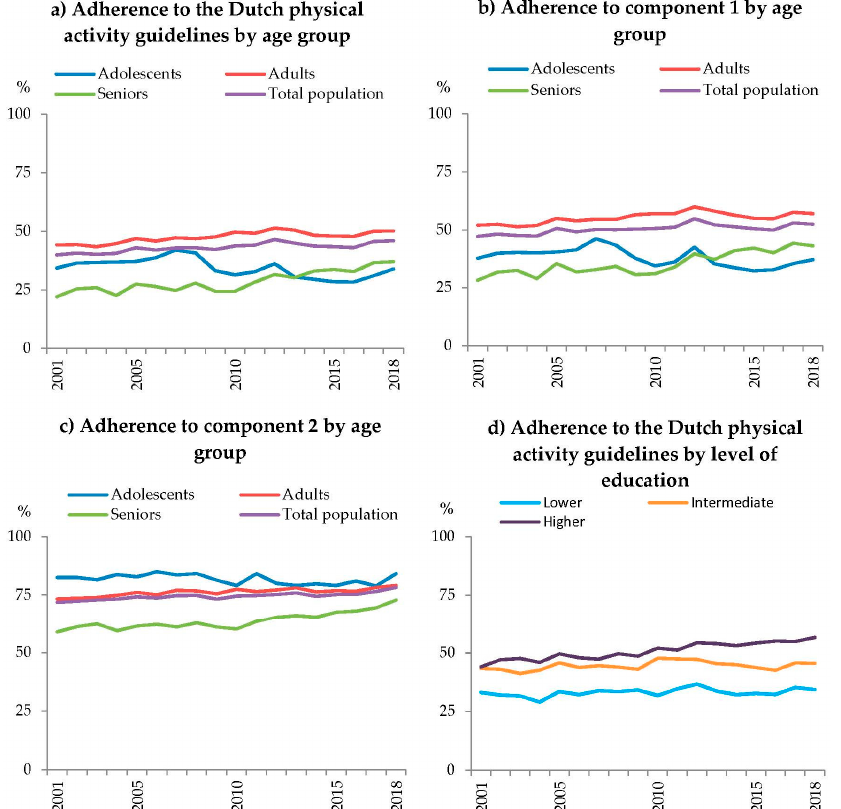
Figure 1. Adherence levels to the Dutch physical activity guidelines (%) consisting of component 1; 150 moderate-and vigorous intense physical activity per week for adults, one hour per day for adolescents and component 2; two times per week bone and muscle strengthening activities for adults, three times for adolescents, stratified by age groups (12–17, 18–64, 65 + ) and level of education. ( a ) Adherence to guidelines for age groups, ( b ) adherence to component 1 for age groups, ( c ) adherence to component 2 for age groups, ( d ) adherence to the guidelines by level of education.